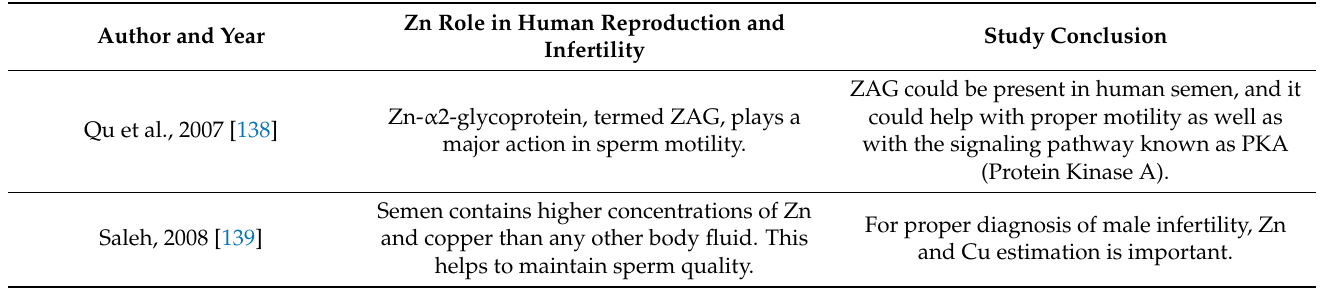
Table 1. Important investigations into the roles of Zn in human reproduction and human male infertility and its implications conducted in the last 13